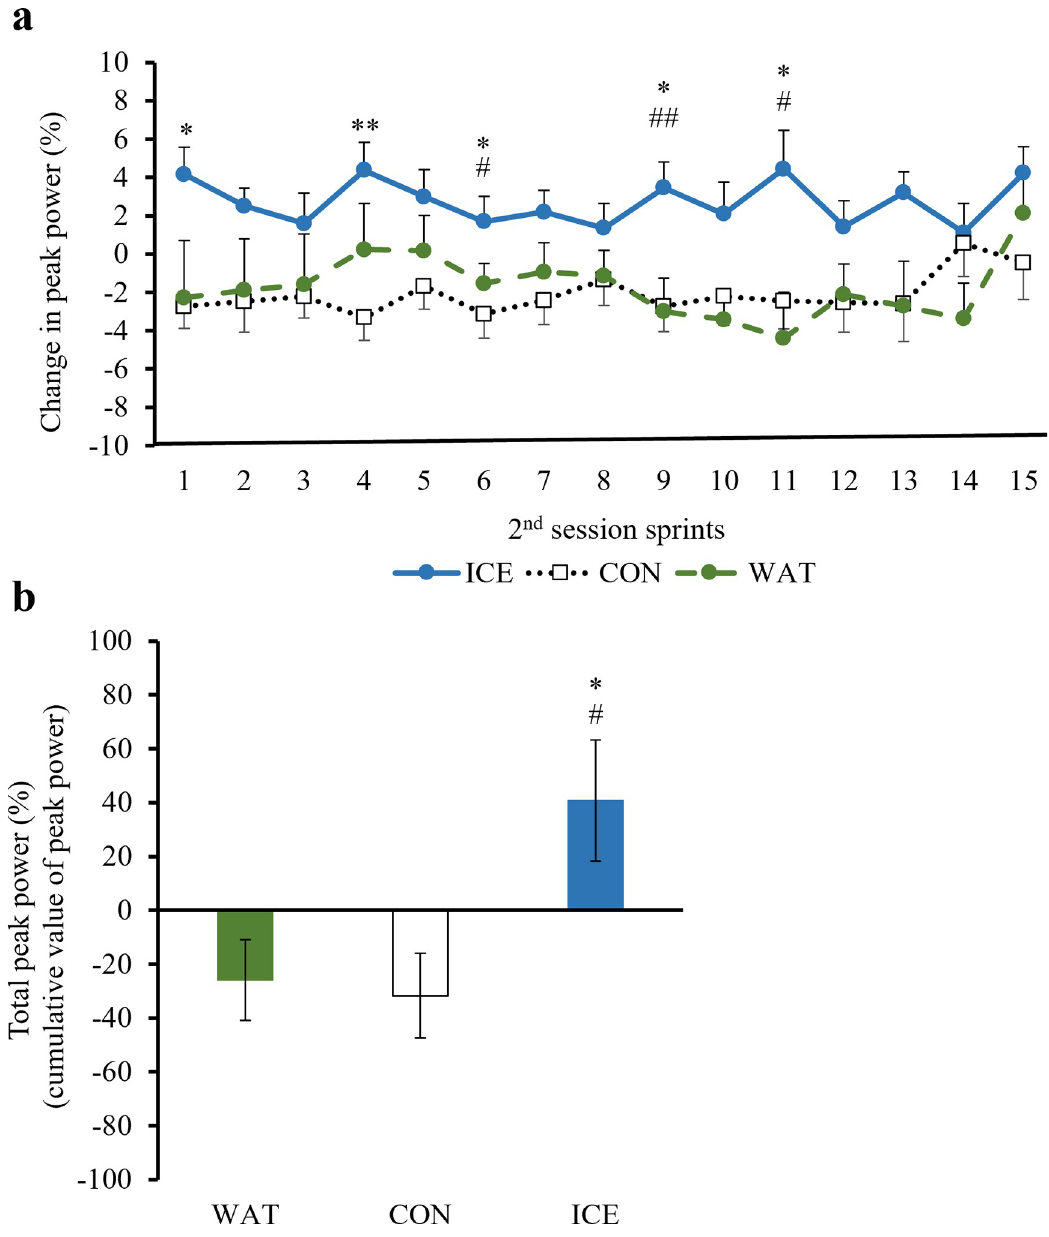
Fig 2. Peak power. ICE: − 2˚C-ice slurry; CON: 30˚C-beverage; WAT: 30˚C-water. The changes in the peak power (a) and total peak power (b) during the 2 nd session in the ICE, CON, and WAT groups. The changes in the peak power (%) were calculated relative to the value at the end of the 15 th sprint of the 1 st session. Values are expressed as the means ± SE of the 12 participants, � p < 0.05, �� p < 0.01 ICE vs. CON, #p < 0.05, ##p < 0.01 ICE vs. WAT. higher in the ICE group as compared with the those in the CON or WAT group. The total peak power was also significantly higher in the ICE group than that in the CON (p = 0.023) and WAT (p = 0.027) groups. There were no significant differences in the total mean power among the groups. No significant differences were observed between the CON and WAT groups.